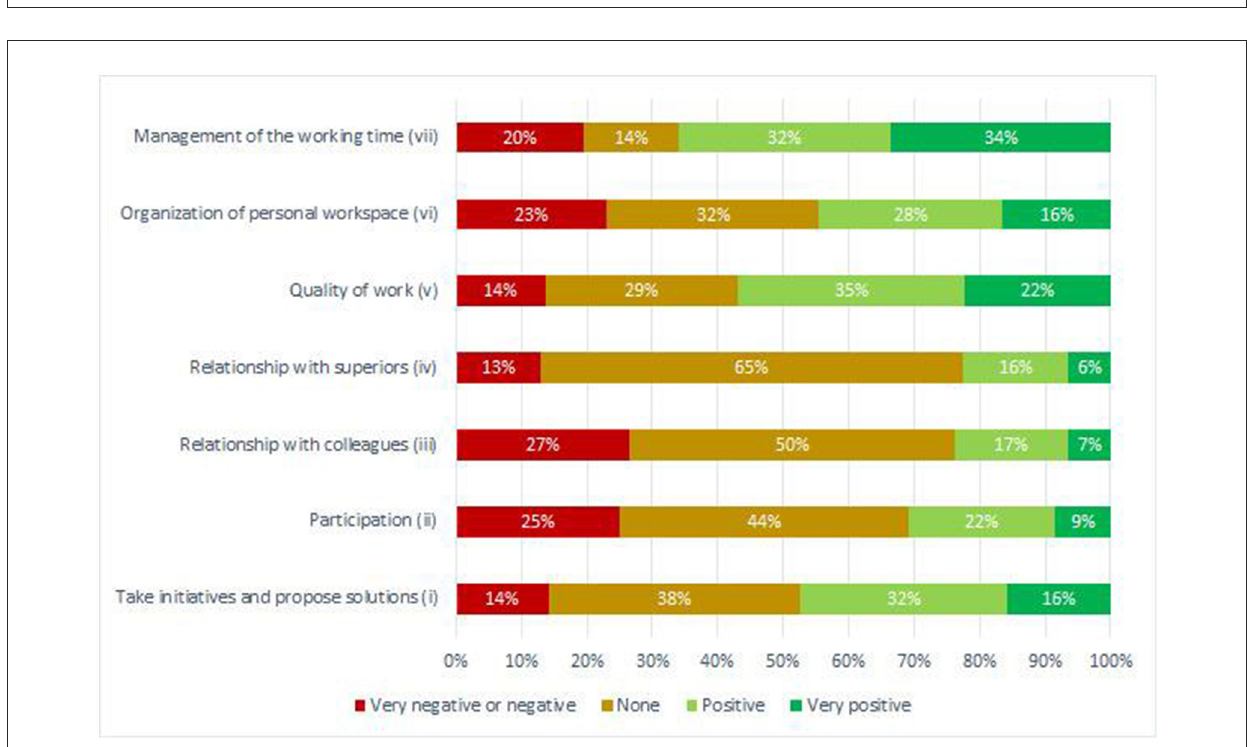
FIGURE2 Perception of the impact of WFH on: (i) ability to take initiatives and propose solutions in the workplace; (ii) participation in the working context; (iii) relationship with colleagues; (iv) relationship with superiors; (v) quality of work; (vi) organization of personal environment and workspace; (vii) management of the working time. Very negative and negative rates have been combined due to very low frequencies ( ≤ 3%) of the very negative rate.